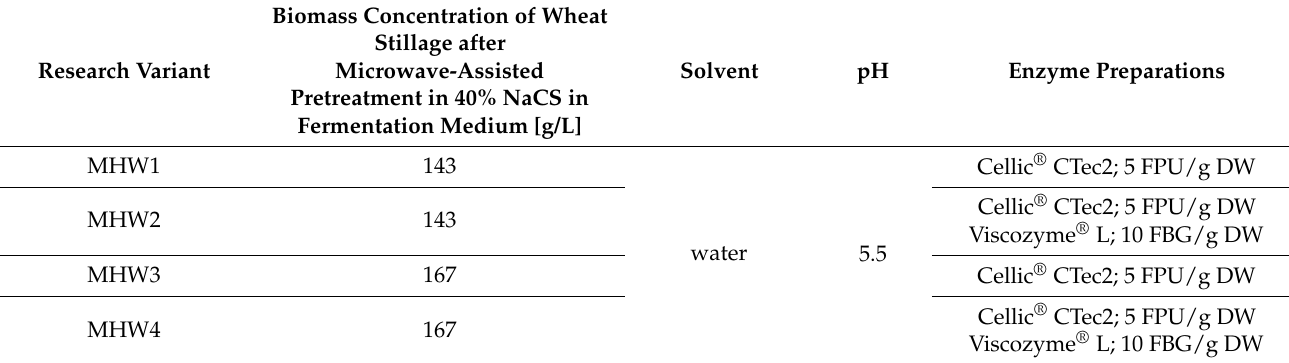
Table 3. Characteristics of experimental